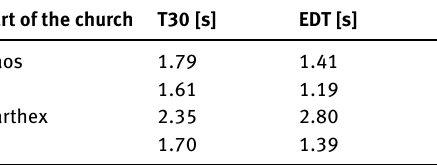
Table 1. Mean values of Reverberation Time and Early Decay Time for Ljubostinja church and Naupara church. Part of the church T30 [s] EDT